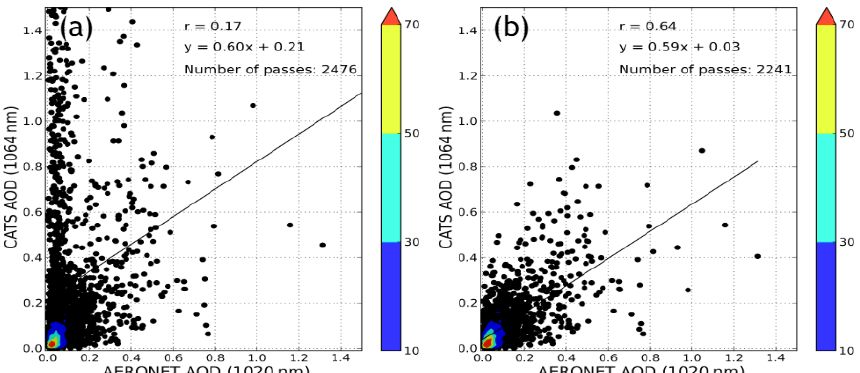
Figure A1. Collocated AERONET 1020nm AOD vs. CATS 1064nm AOD (a) without CATS QA applied and (b) with CATS QA applied. CATS V2-01 aerosol products were used in constructing this